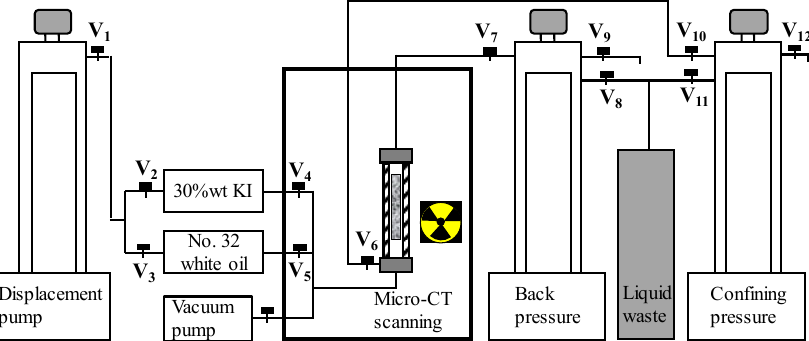
Figure 2. Flow chart of experimental apparatus.